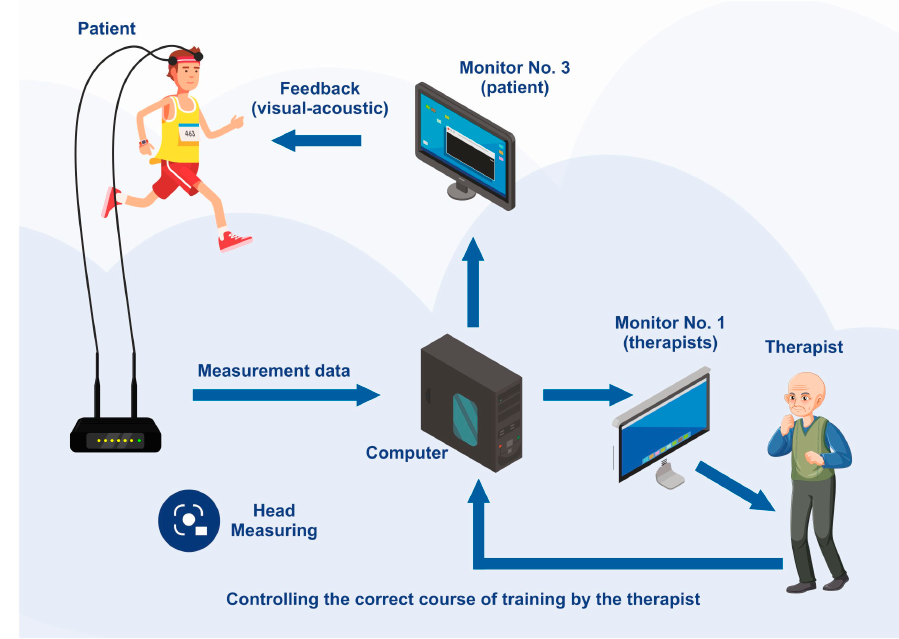
Figure 1. Diagram of biofeedback functioning (own diagram).